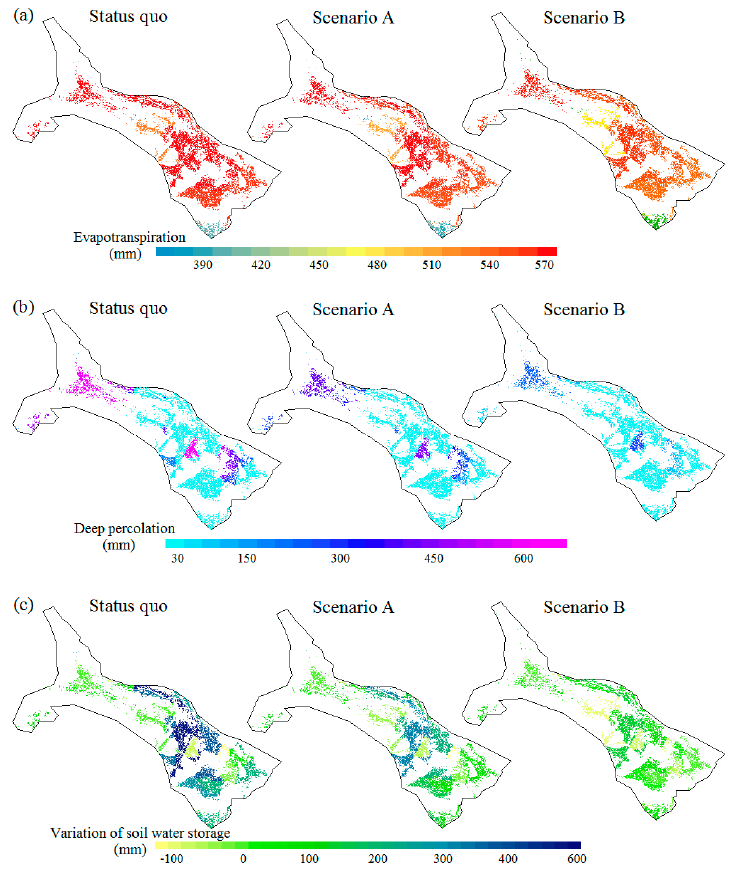
Figure 9. Results of evapotranspiration ( a ), groundwater recharge ( b ) and variation of soil water storage in vadose zone ( c ) in the farmland cultivated with maize and spring wheat of study area under different water saving irrigation practice scenarios.